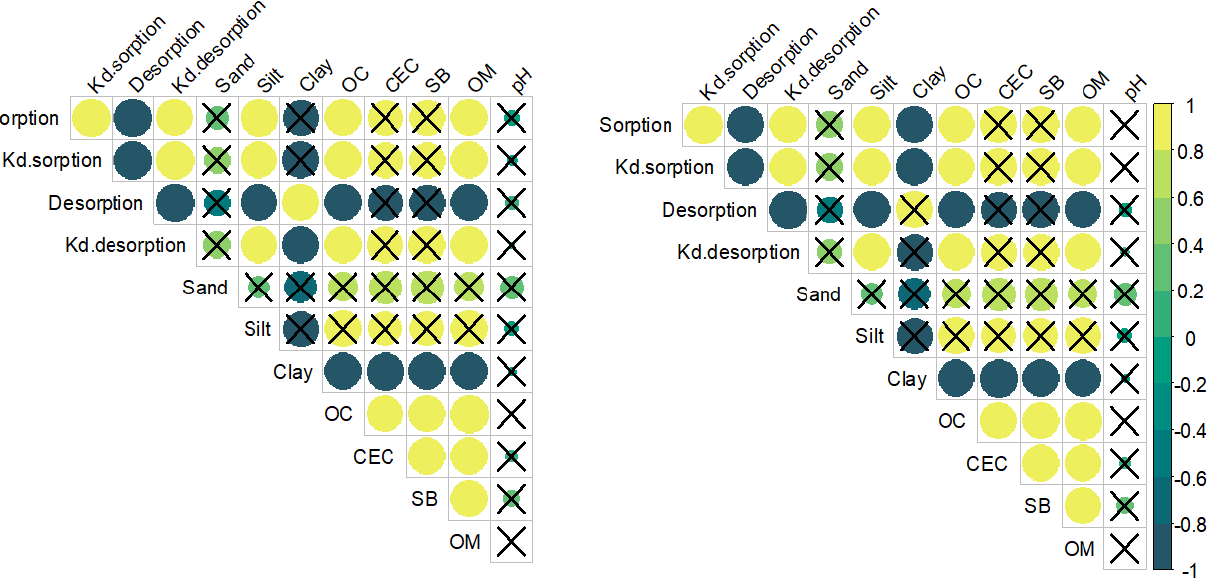
Figure 3. Correlation matrix of sorption–desorption processes and soil system properties for nano MTZ ( left ) and conventional MTZ ( right ). Symbols represent Pearson correlation coefficient ( p < 0.05) and symbols covered by an X represent non-significant correlation coefficients ( p > 0.05).